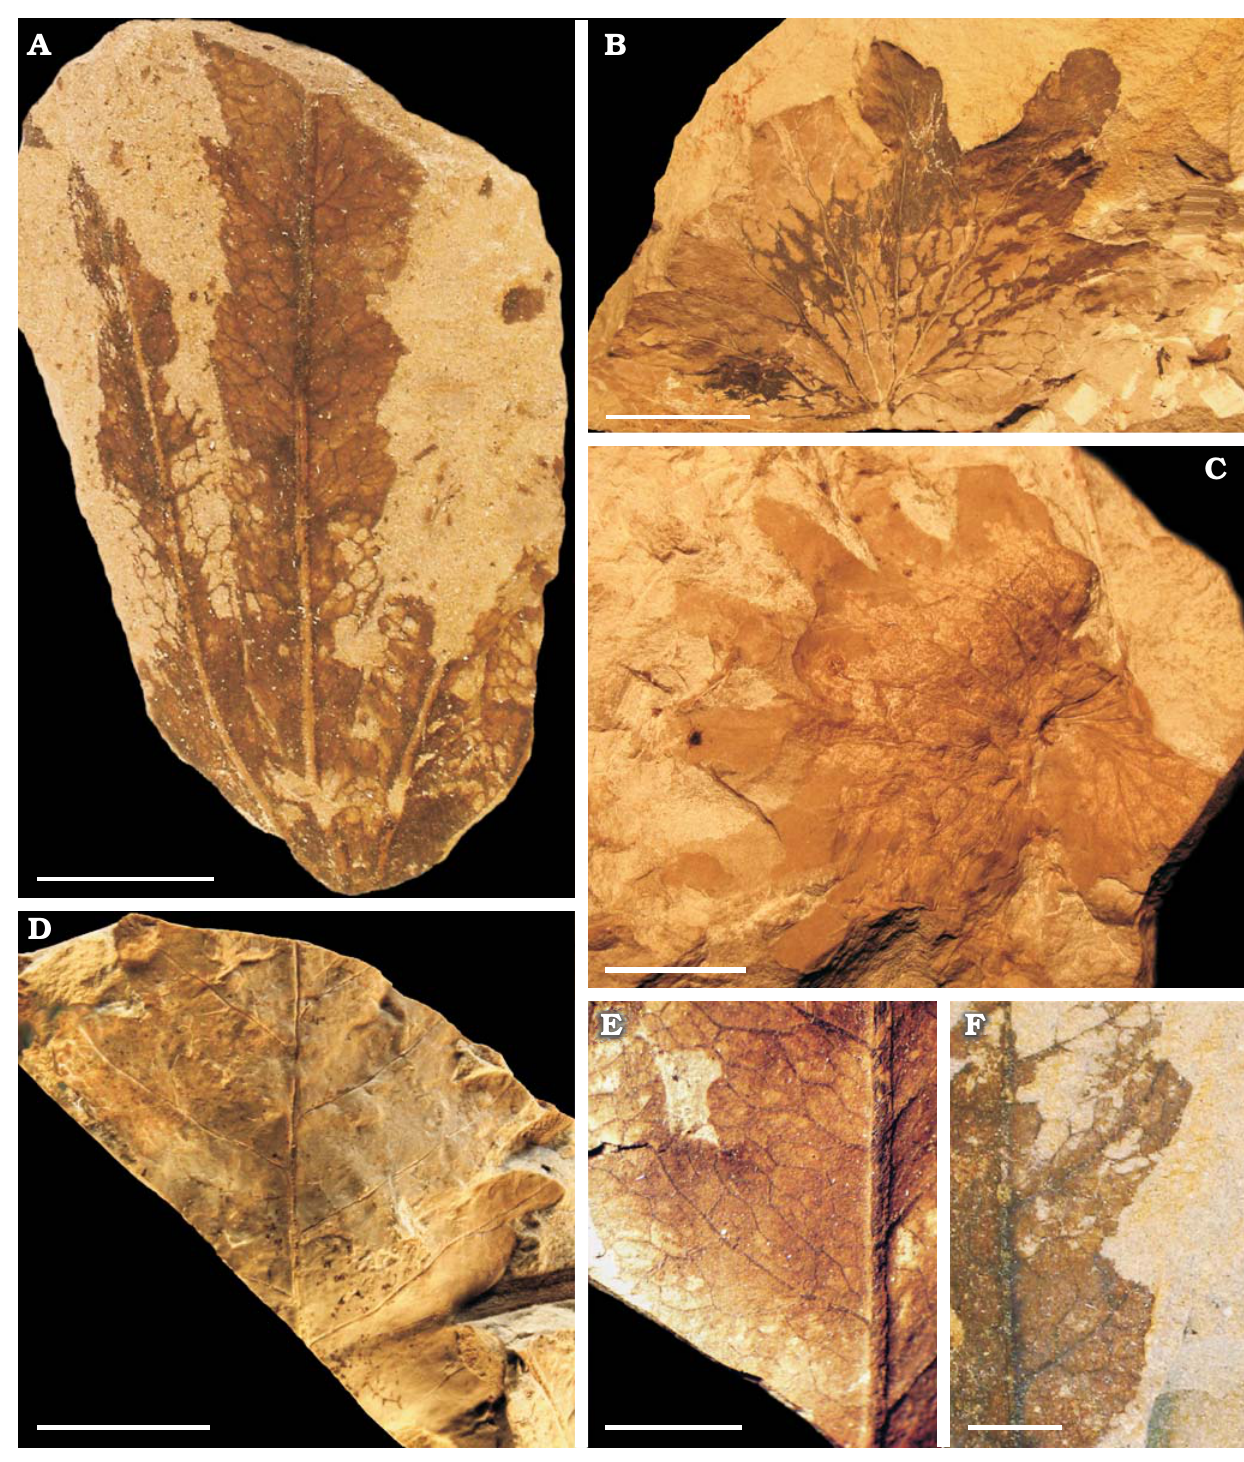
Fig. 6. Dipterid ferns from Barreal-Calingasta, San Juan Province, Argentina. A , D – F . Dictyophyllum tenuifolium Stipanicic and Menéndez, 1949 emend. Bonetti and Herbst, 1964; Cortaderita Formation (Ladinian, Middle Triassic). A . PBSJ 412a. D . PBSJ 1051. E . PBSJ 412b. F . PBSJ 412c. B , C . Hausmannia faltisiana Stipanicic and Menéndez, 1949 emend. herein; Barreal Formation (Anisian, Middle Triassic). B . BAPb 6248. C . BAPb 6254. Scale bars: A, C, D, 10 mm; B, 20 mm; E, F, 5